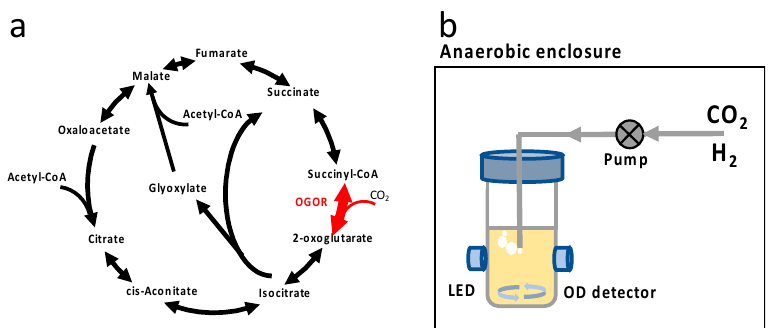
Figure 1. ( a ) OGOR enzyme and tricarboxylic cycle with glyoxylate bypass in E. coli . For reversible enzyme reactions, the enzyme is symbolized with a double-ended arrow. For OGOR reaction, one CO 2 molecule is assimilated, and succinyl-CoA is converted to 2-oxoglutarate. ( b ) Anaerobic bioreactor for evolution. The cultivation vessel is placed in an anaerobic enclosure, and the optical density is monitored with a light-emitting diode (LED) and a photodetector. Gas pack (not shown) or N 2 purge is used to create anaerobic conditions for elevated CO 2 conditions and absence of CO 2 , respectively. H 2 and CO 2 are generated via chemical reaction and actively pumped into the culture. Growth data are wirelessly transmitted to the external computer for post-processing.